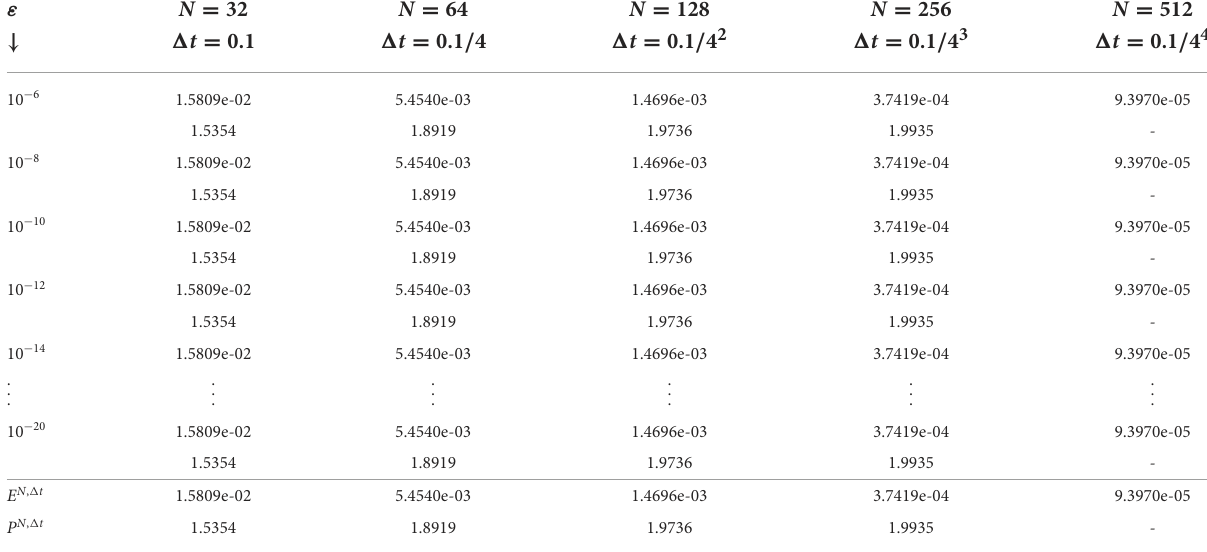
TABLE 2 Maximum absolute error and rate of convergence of the scheme for Example